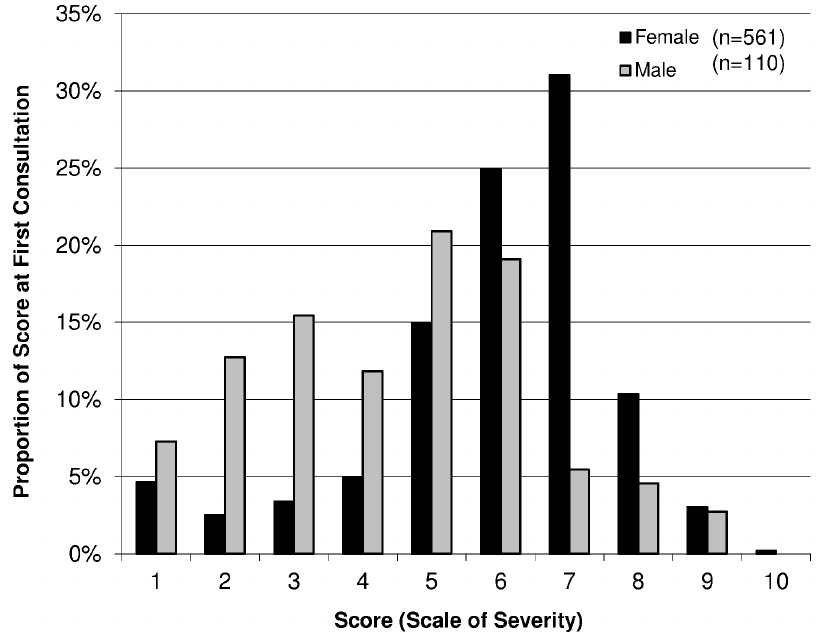
Figure 3. Score of patients . Patients (n=671) whose Scale of Severity was assessed at their first mental health consultation, Timurgara district hospital, Pakistan (May - December 2012).